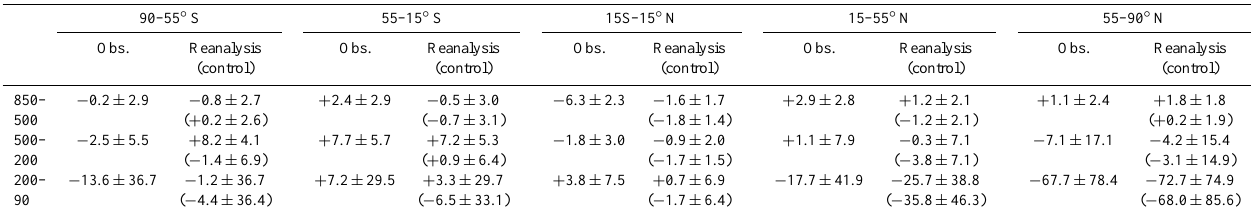
Table 2. Linear trend (slope in ppb ( 8years ) − 1 ) and standard deviation (in ppb) of O 3 derived from the WMO ozonesonde observations, the control run, and the reanalysis during 2005–2012.